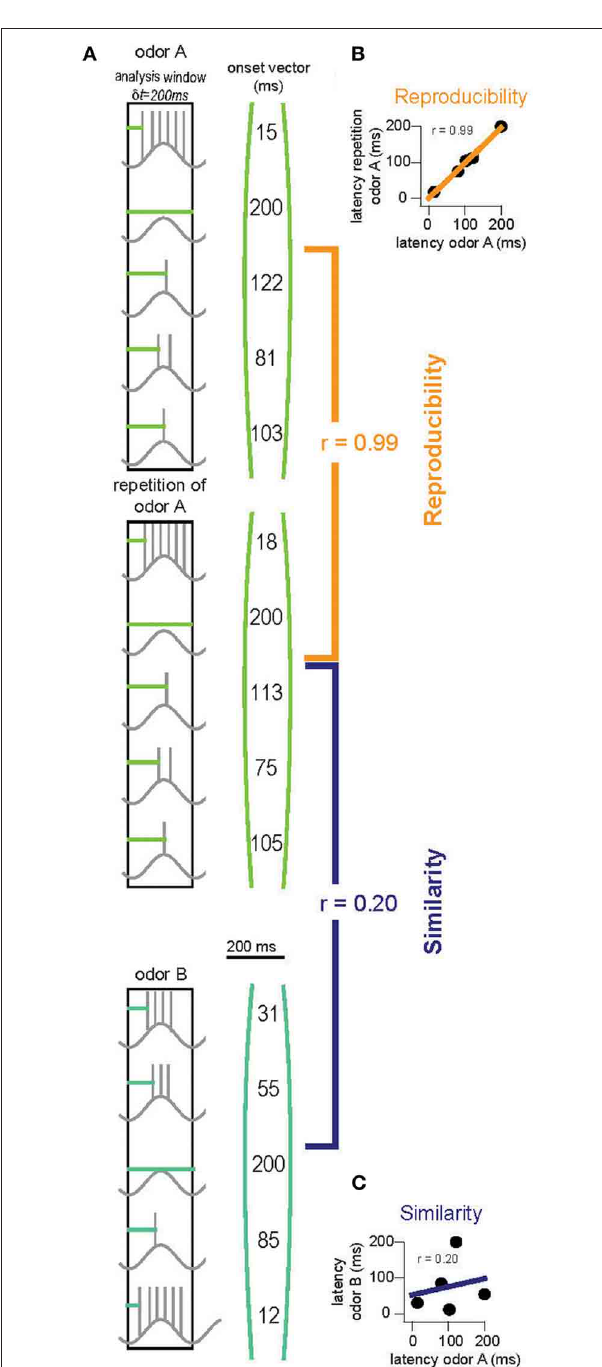
FIGURE 6 | Quantifying stimulus separation in the OB. (A) Onsets of activity ( horizontal light and dark green lines ) of all M/TCs are collected into “onset vectors” ( right ). Each odor is presented twice with different random seeds for noise generation. “Reproducibility” is calculated by correlating onset vectors with a repetition of the same odor [orange, (B) ]. “Similarity” is determined by correlating onset vectors for responses to two different odors [purple, (C) ]. This is repeated eight times with different random seeds for odor and noise generation. Separation of two odors is ensured when the resultant reproducibility values are significantly higher than the similarity values (unpaired t -test).